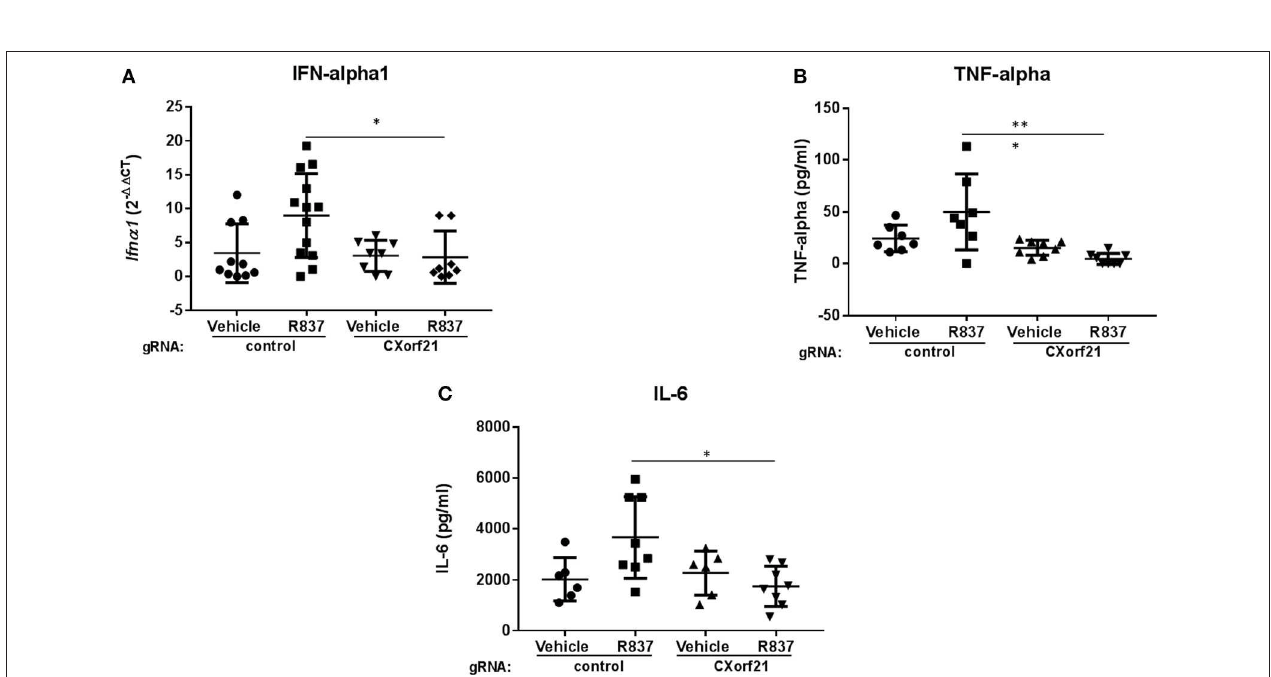
FIGURE 5 | Knockdown of CXorf21 decreases TLR7-stimulated IFN-alpha1, TNF-alpha, and IL-6. (A) RT-qPCR of Ifna1 mRNA expression from 46, XX female primary monocytes transfected with control (Con) or CXorf21 -specific gRNA (CX21). Ligand stimulations were performed for 24h with vehicle (Veh) or R837 (1 µ M). Fold changes show relative expression compared to female Con-Veh. (B) TNF-alpha and (C) IL-6 plots show cytokine production in 46, XX female primary monocytes transfected with control (Con) or CXorf21-specific gRNA (CX21). Ligand stimulation was performed for 24h with vehicle (Veh) or R837 (1 µ M) and cytokine in media detected via ProcartaPlex TM Platinum Human Multiplex Assays. Error bars represent SEM. * p > 0.05, *** p < 0.001.